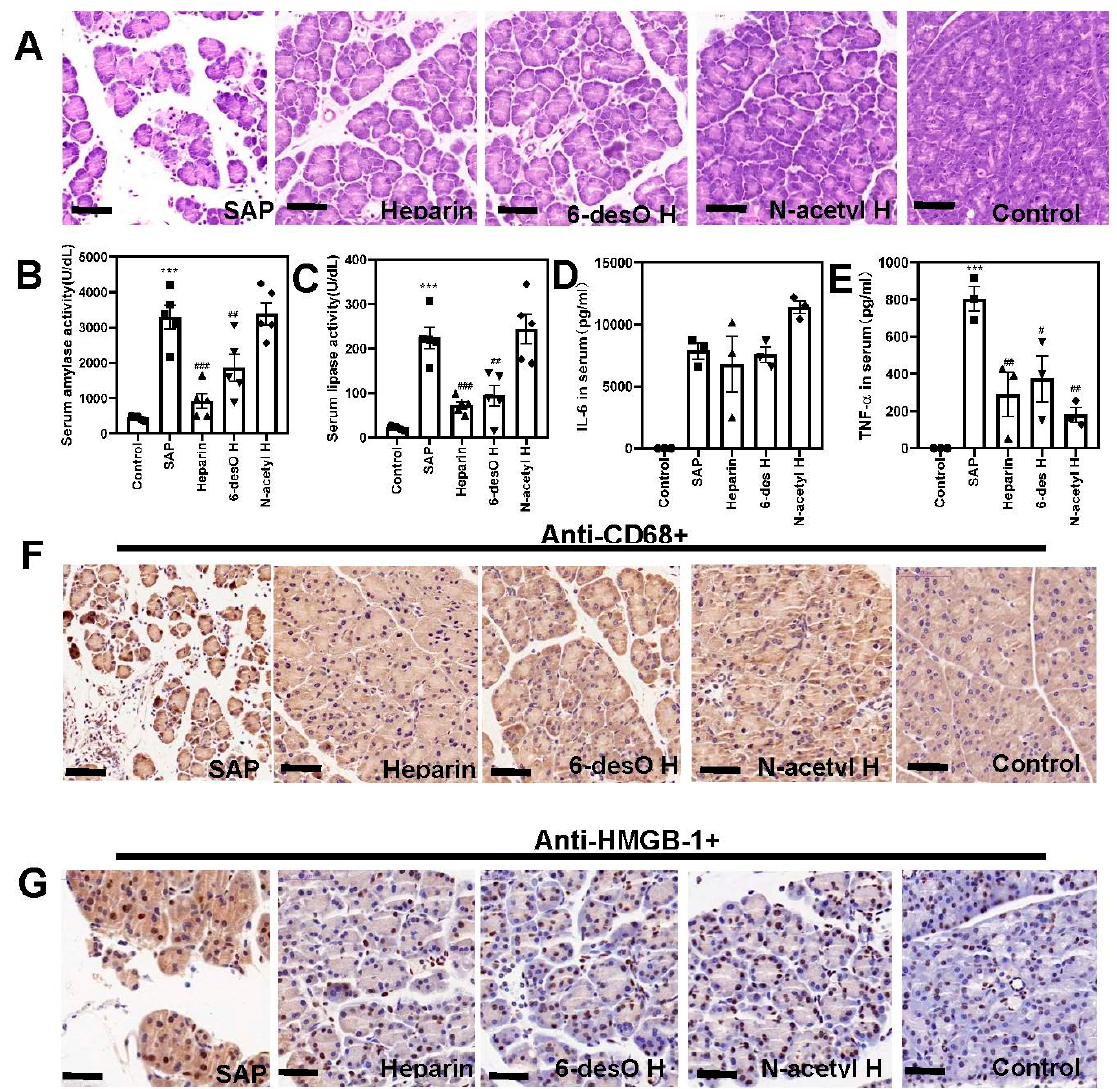
Figure 6. Heparin alleviated caerulein and LPS induced SAP. ( A ) The representative images for the H&E staining of the pancreas. ( B ) The serum α -amylase activity analysis. ( C ) The serum lipase activity analysis. ( D , E ) Determination of the TNF- α ( D ), and IL-6 ( E ) in the serum. ( F ) Analysis of the macrophage infiltration of the pancreas by immunohistochemistry (anti-CD68+). ( G ) Pancreatic HMGB-1 distribution by immunohistochemistry (anti-HMGB-1+) (Scale bar=20 µm. # p < 0.05, ## p < 0.01, ### p < 0.001, the SAP group vs. other groups; *** p < 0.001, SAP vs. control groups).